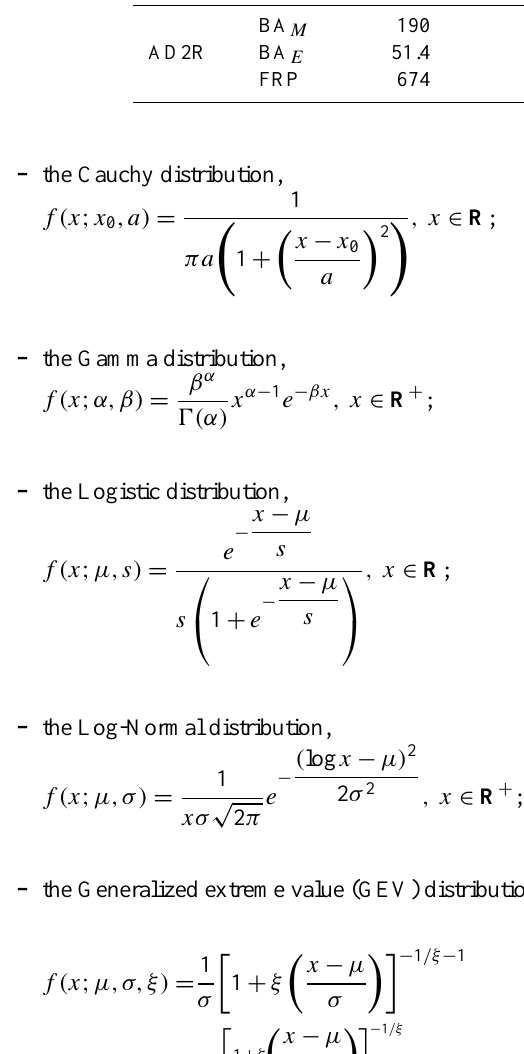
Table 1. AD2R values for all different distributions and for all data sets. The AD2R values for the chosen distributions are in bold.